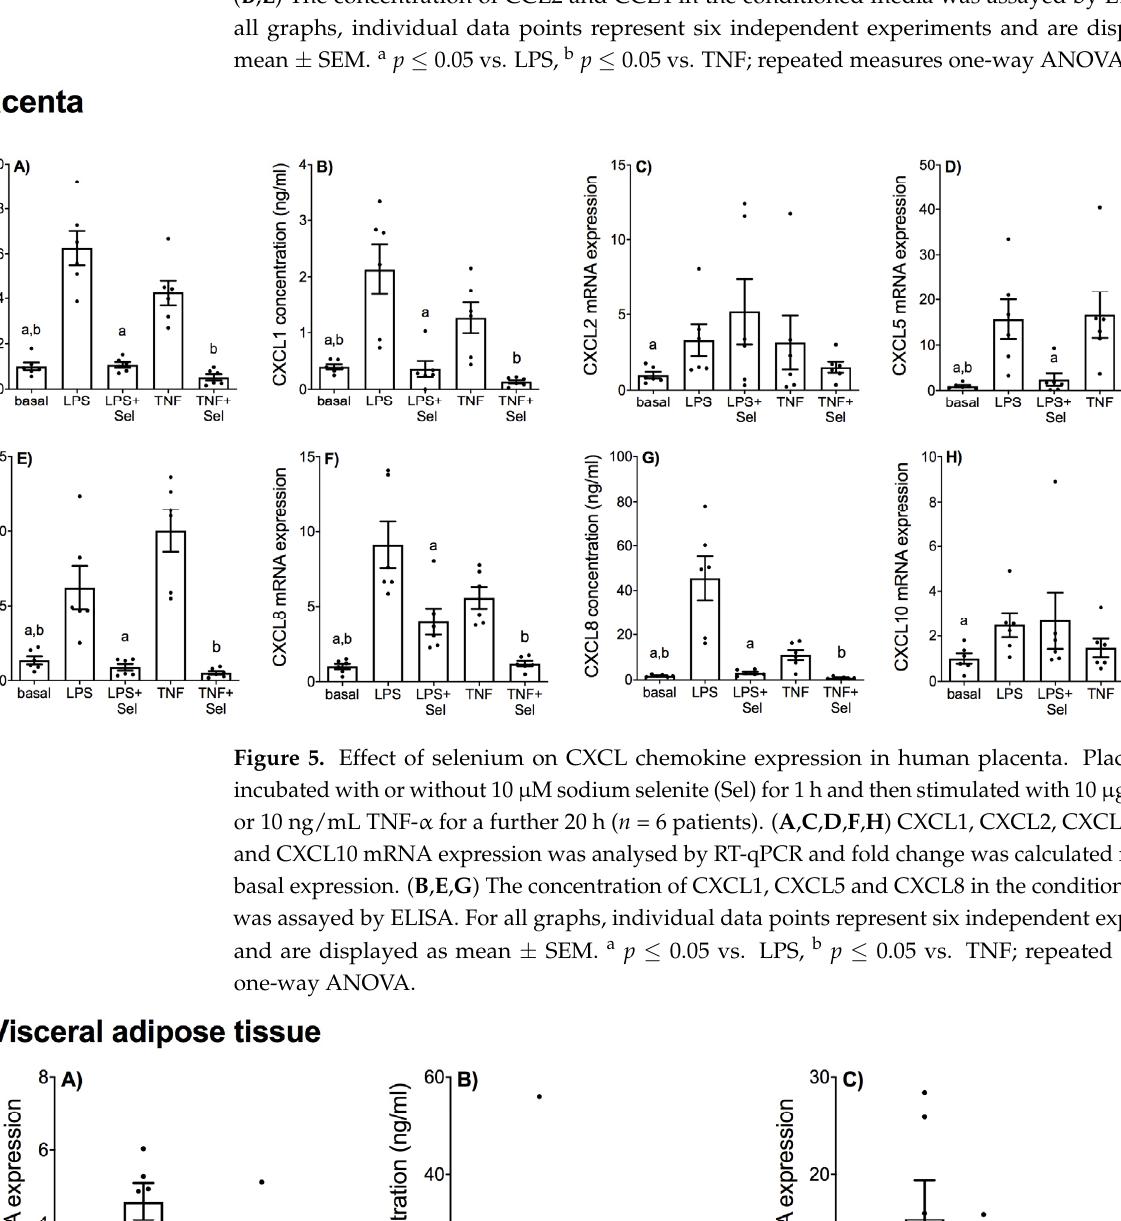
Figure 4. Effect of selenium on CCL chemokine expression in human placenta. Placenta was incu- bated with or without 10 µM sodium selenite (Sel) for 1 h and then stimulated with 10 µg/mL LPS or 10 ng/mL TNF- α for a further 20 h ( n = 6 patients). ( A , C , D , F ) CCL2, CCL3, CCL4 and CCL8 mRNA expression was analysed by RT-qPCR and fold change was calculated relative to basal expression. ( B , E ) The concentration of CCL2 and CCL4 in the conditioned media was assayed by ELISA. For all graphs, individual data points represent six independent experiments and are displayed as mean ± SEM. a p ≤ 0.05 vs. LPS, b p ≤ 0.05 vs. TNF; repeated measures one-way ANOVA.